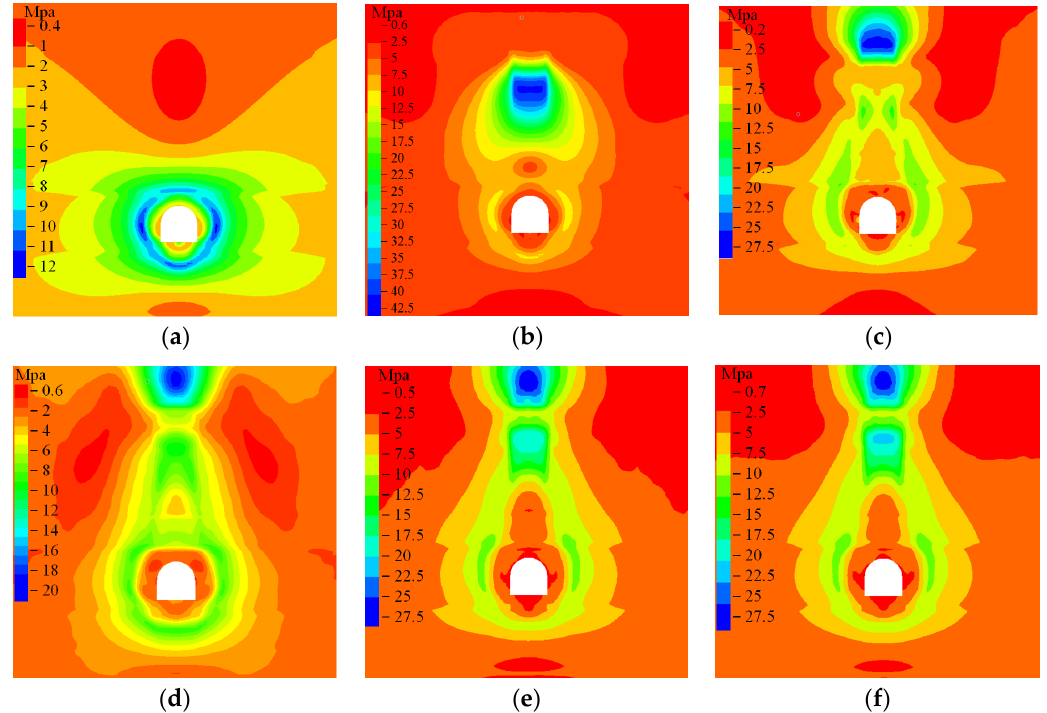
Figure 3. Evolution Nephogram of Maximum Principal Deviatoric Stress in Surrounding Rock of Roadway under Dynamic Load Disturbance. ( a ) before dynamic load disturbance; ( b ) dynamic load disturbance of 0.01 s; ( c ) dynamic load disturbance of 0.03 s; ( d ) dynamic load disturbance of 0.05 s; ( e ) dynamic load disturbance of 0.07 s; ( f ) dynamic load disturbance of 0.09 s.